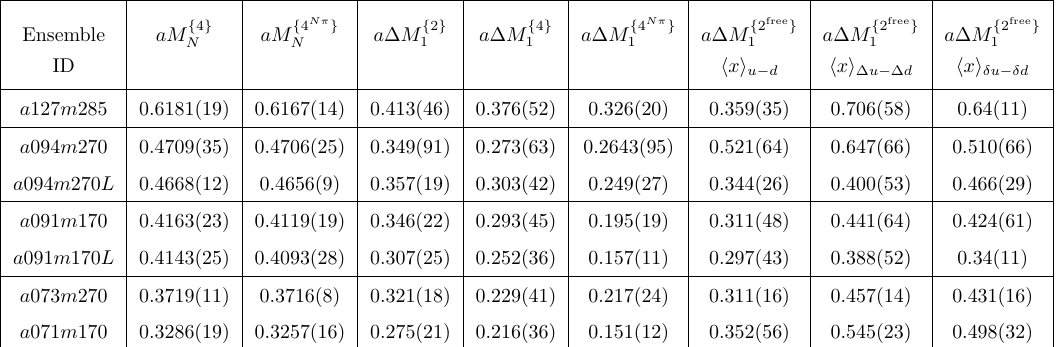
Table 3 . Results for the nucleon mass aM { 4 }